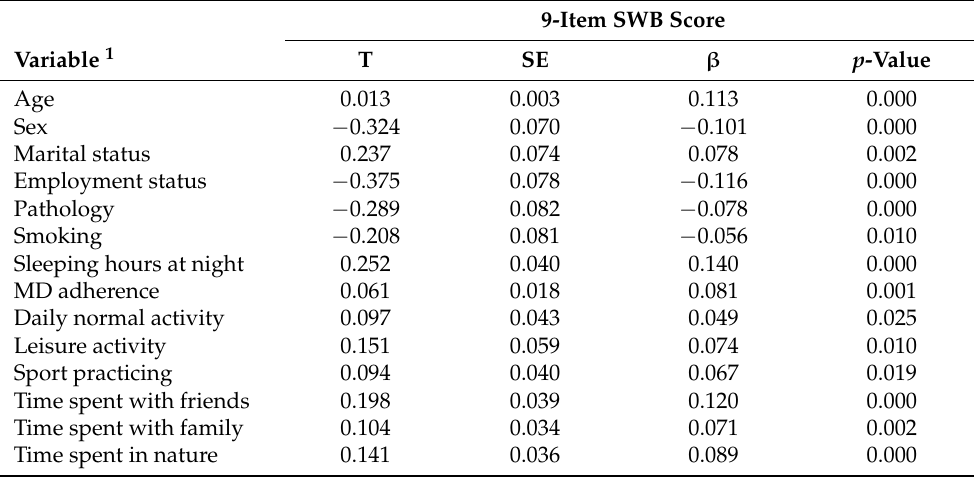
Table 7. Multiple linear regression model to assess the relationship between the pooled 9-item SWB score and sociodemographic, health related and lifestyle